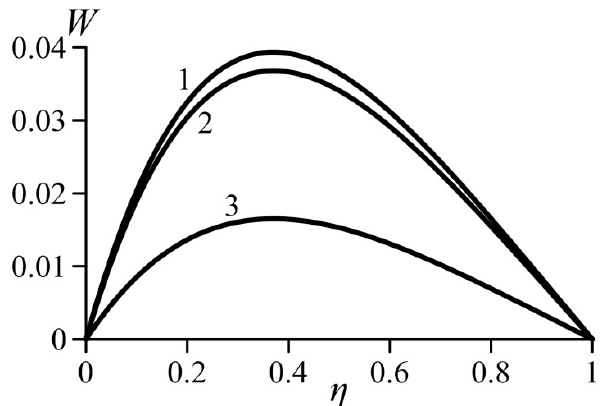
Figure 3. Effect of the van der Waals number Wa a on the velocity profiles, βθ w = 0.01. 1—ideal gas ( Wa a = Wa b = 0), 2— Wa a = 0.1 ( Wa b = 0.02), 3— Wa a = 0.6 ( Wa b = 0.02).